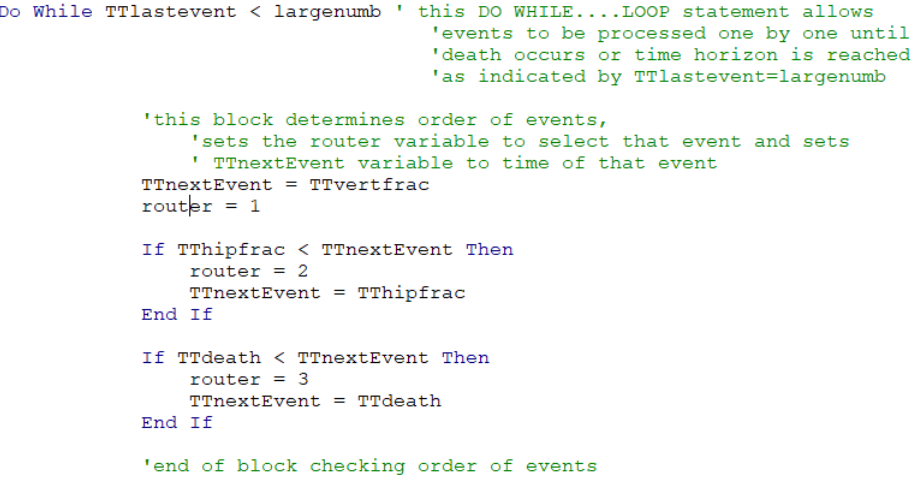
Figure A3. Logic for selecting the next event in the VBA version of the osteoporosis